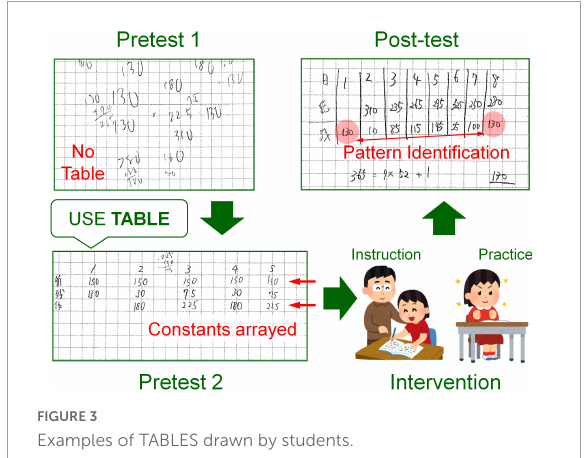
FIGURE3 Examples of TABLES drawn by